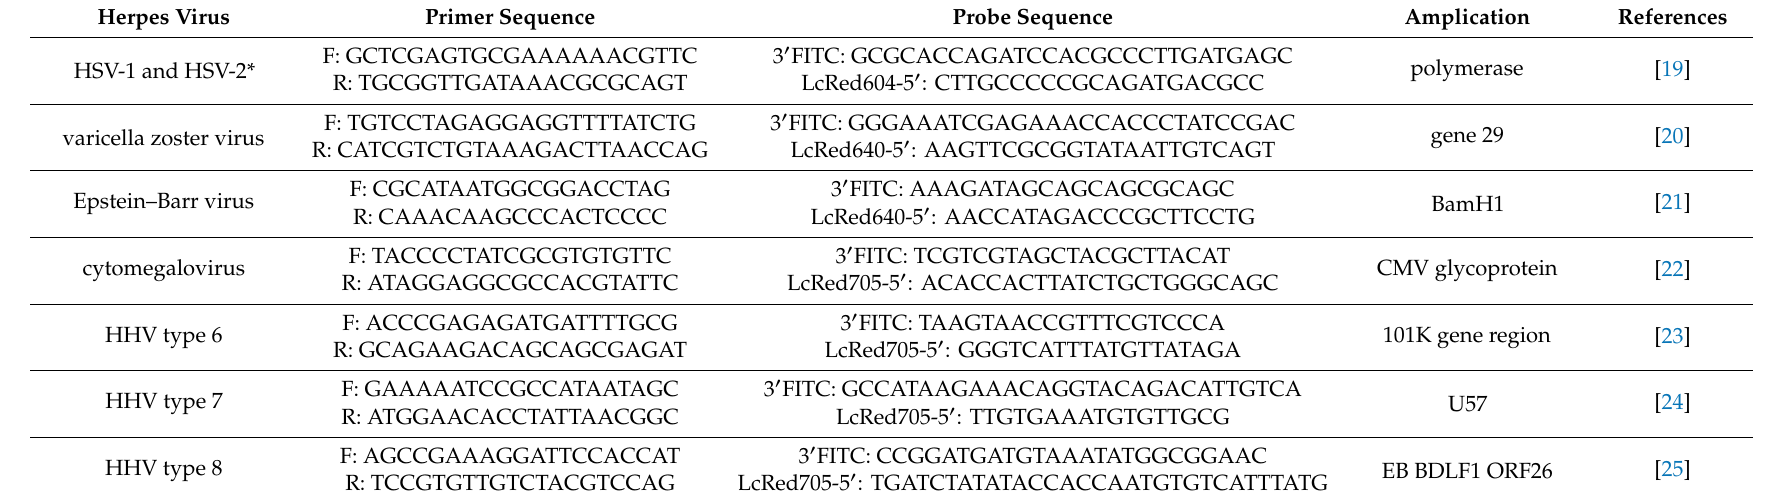
Table 2. Sequences of primers and probes for detecting human herpes viruses using qualitative multiplex